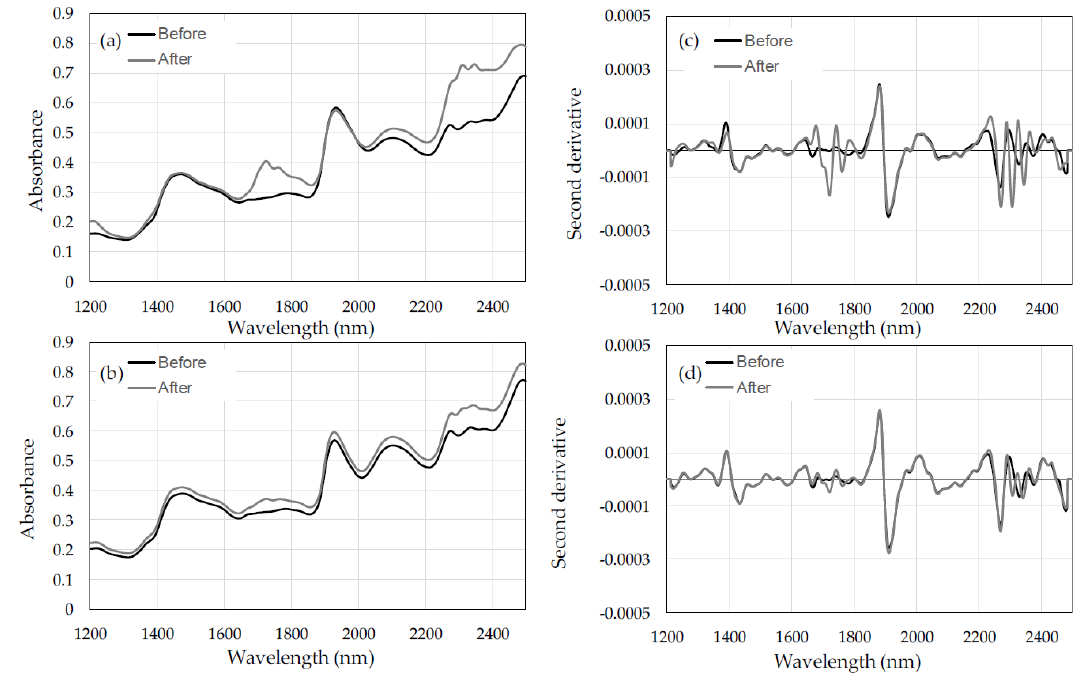
Figure 2. NIR spectra of Cryptomeria japonica ( a , c ) and Chamaecyparis obtusa ( b , d ) flat grain samples. ( a , b ) are raw spectra, and ( c , d ) are pre-processed spectra. Black lines indicate the spectra collected before applying Oil_1, and the gray lines indicate those obtained after applying Oil_1 to the surfaces of the wood samples.